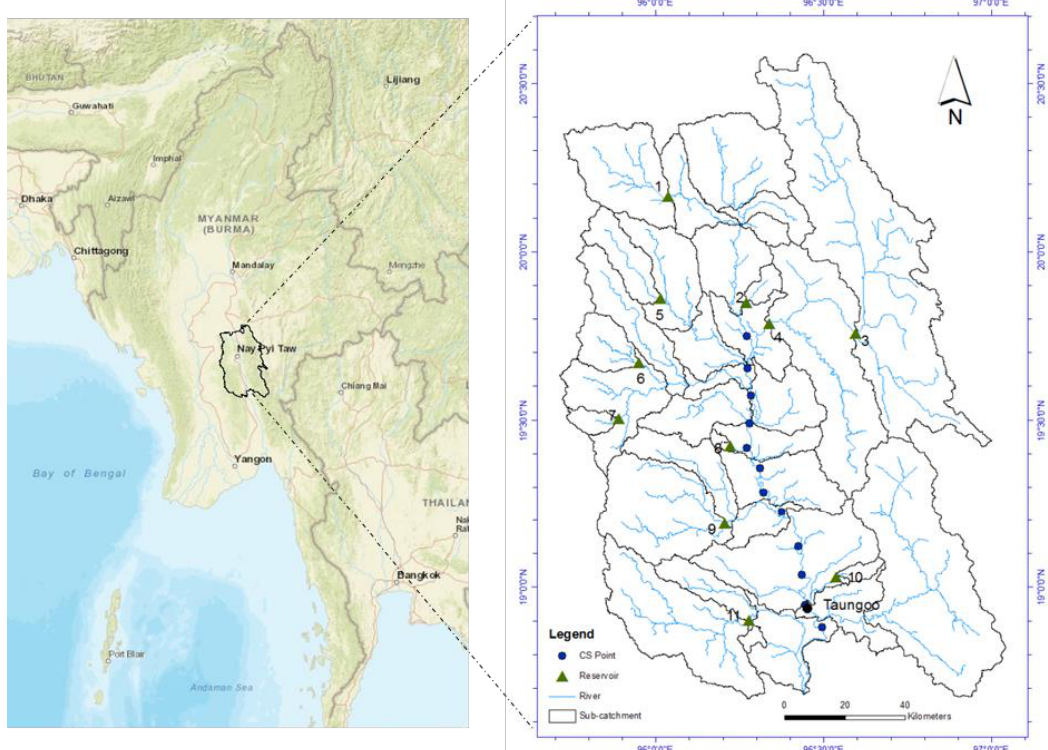
Figure 1. Study area—the Sittaung River basin with 11 reservoirs (salient features of reservoirs are given in Table 1. CS points are the locations where cross-sections were surveyed for this study).